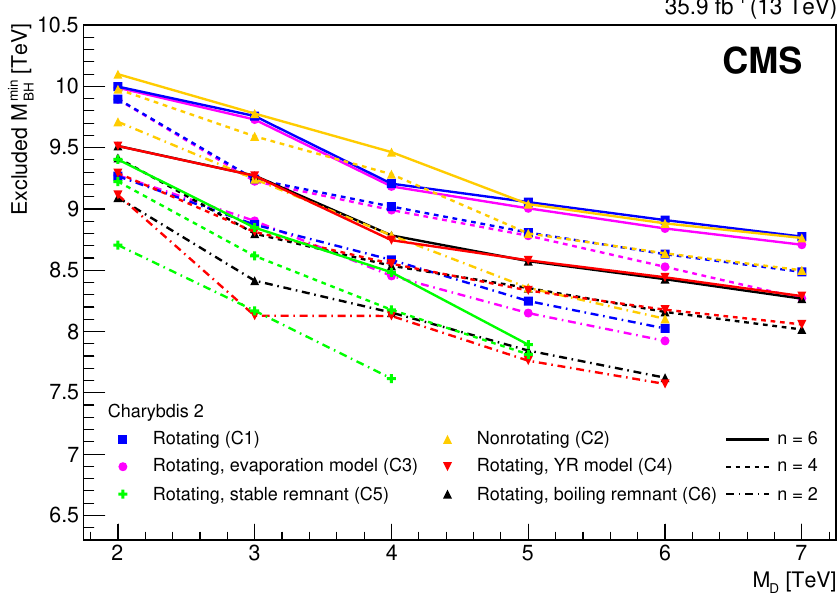
as a function of M D at di(cid:11)erent n for the BH